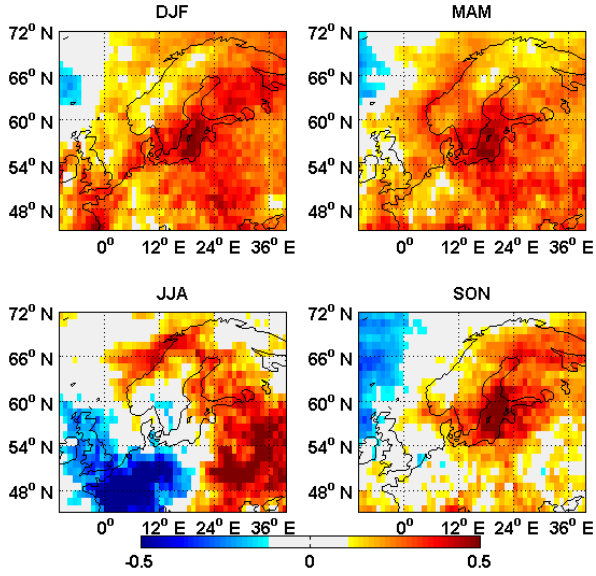
Figure 6. The seasonal spatial patterns of specific humidity anoma- lies (gkg − 1 ) during extreme NO 2 pollution